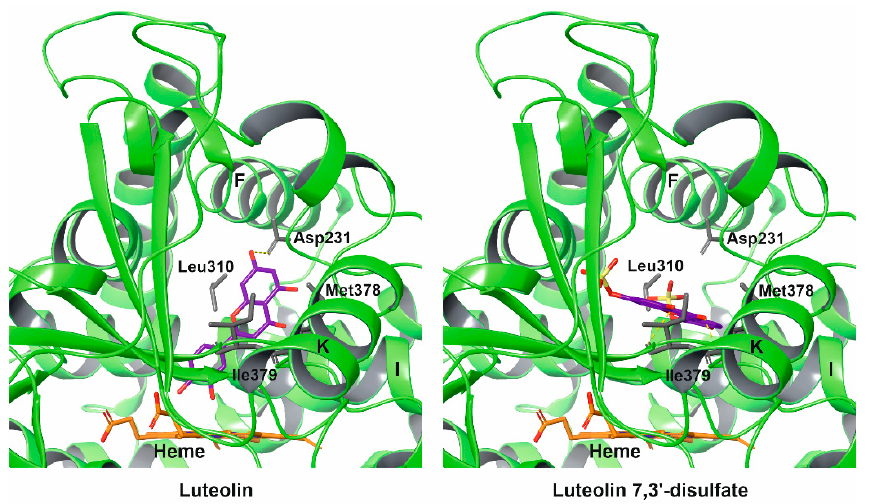
Figure 4. Luteolin and luteolin 7,3 ′ -disulfate docked to the active site of human CYP51A1. The secondary structure of the protein is depicted as a ribbon and colored green. The amino acid side chains are shown as sticks and are colored in grey. The flavonoids and heme are shown as sticks and are colored in magenta and orange, respectively.